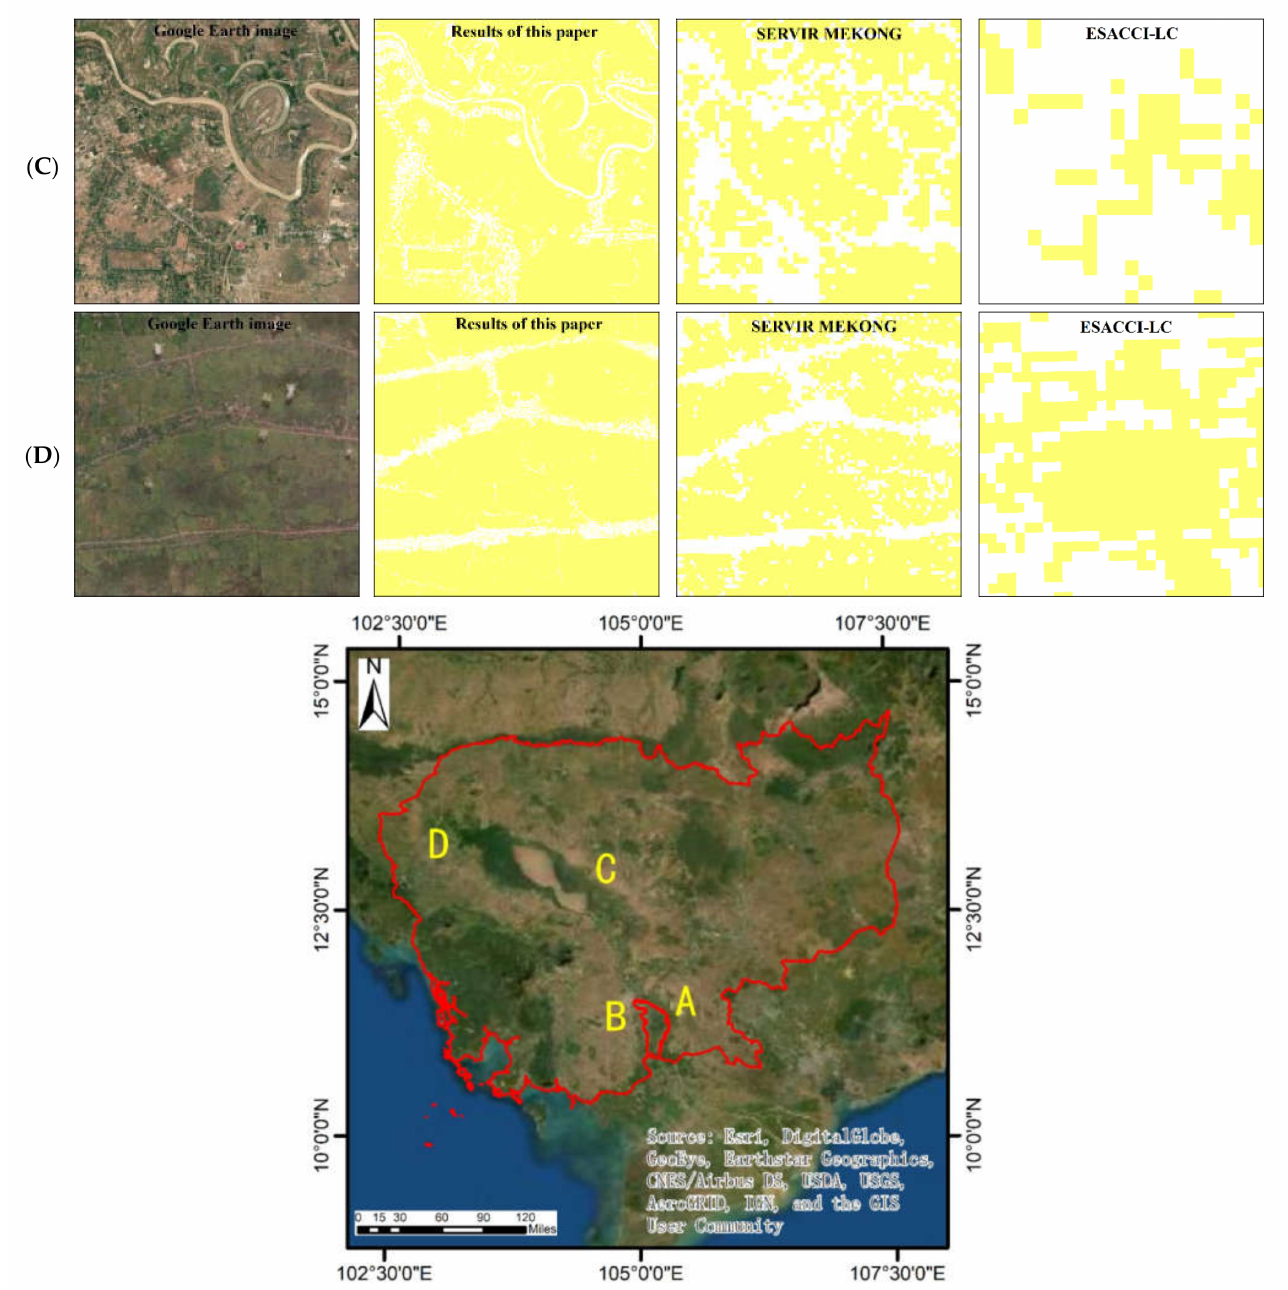
Figure 12. Comparison of the paddy extraction results of each product with Google Earth images. The yellow area represents paddy, and the white area represents